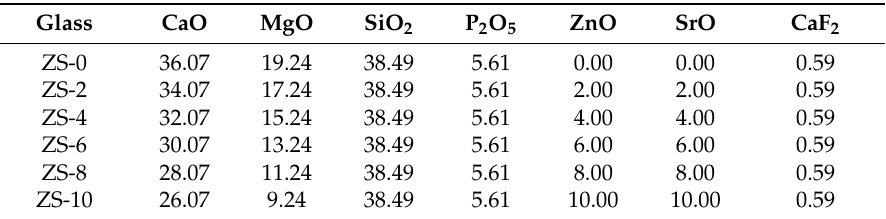
Table 12. Batch compositions of the glasses (mol